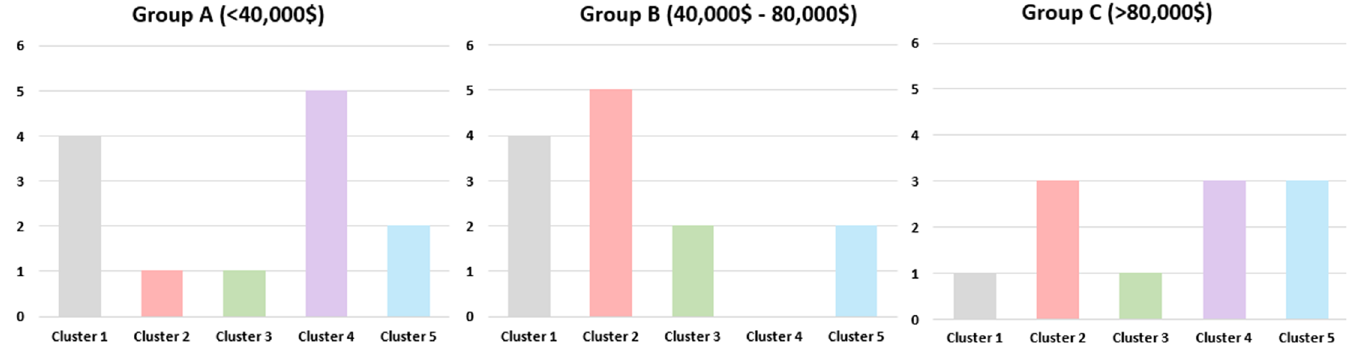
Fig 5. The distribution of different clusters into the three cost categories related to the amount for median Progression-Free Survival (PFS).